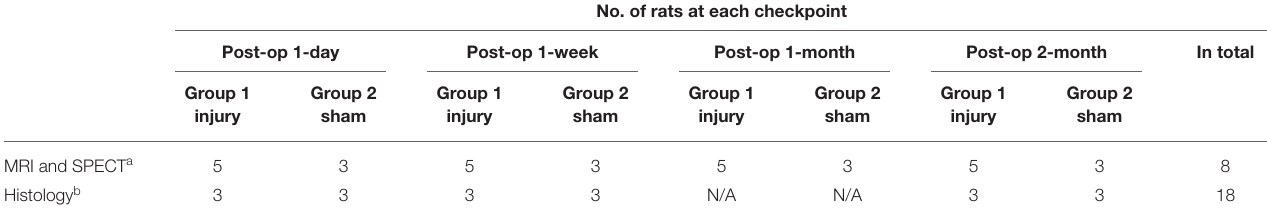
TABLE 1 | Grouping information ( N = 26 in